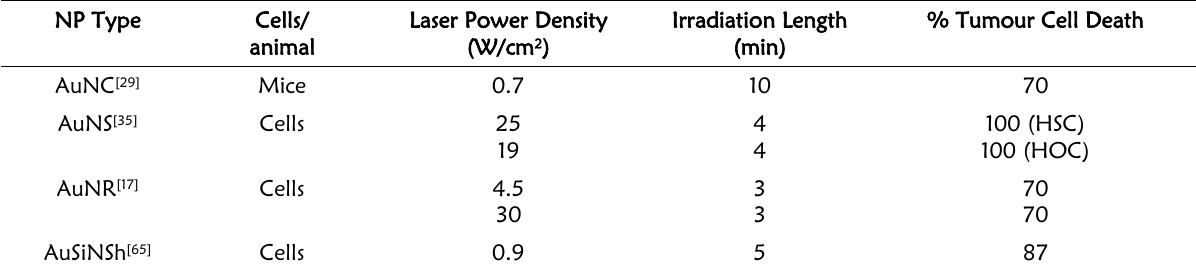
Table 4: Summary of Targeted Cancer Cell Killing Studies by AuNP type. Sources: [17, 29, 35, 65] NP Type